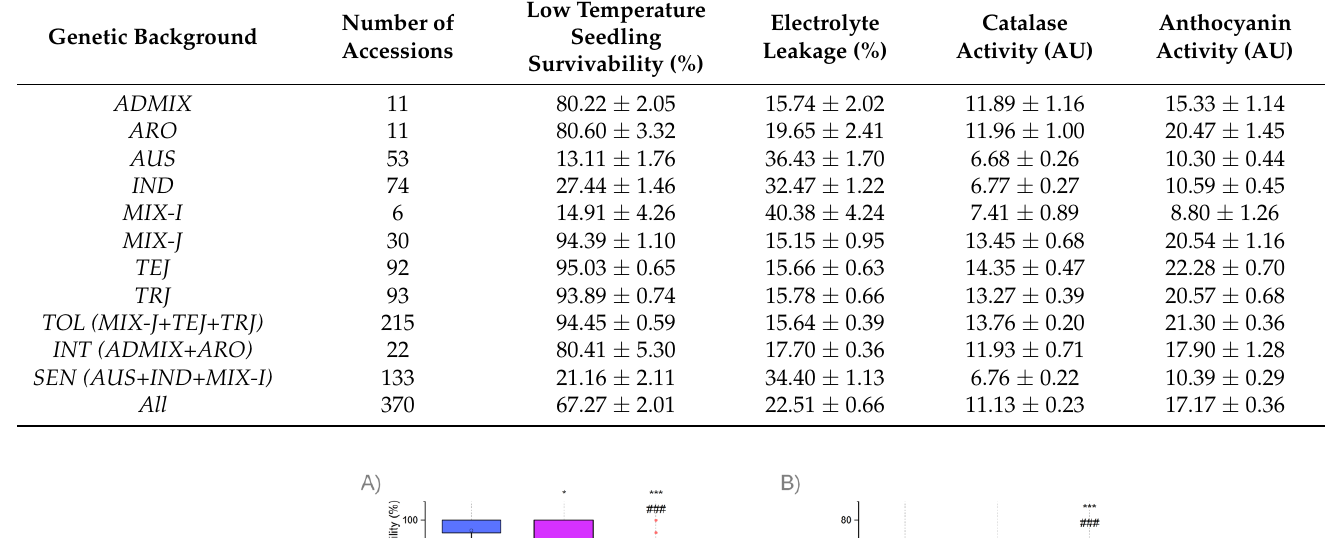
Genetic Background